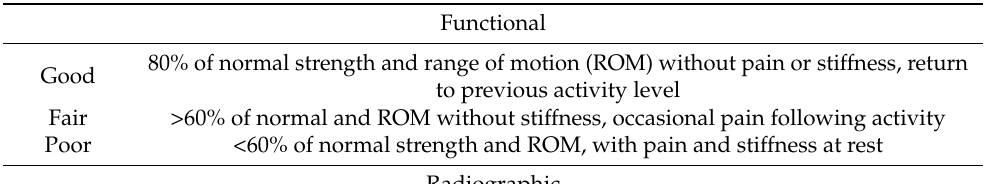
Table 1. Functional and radiographic rating according to McLennan and Ungersma’s criteria (com- pared to the normal ankle).